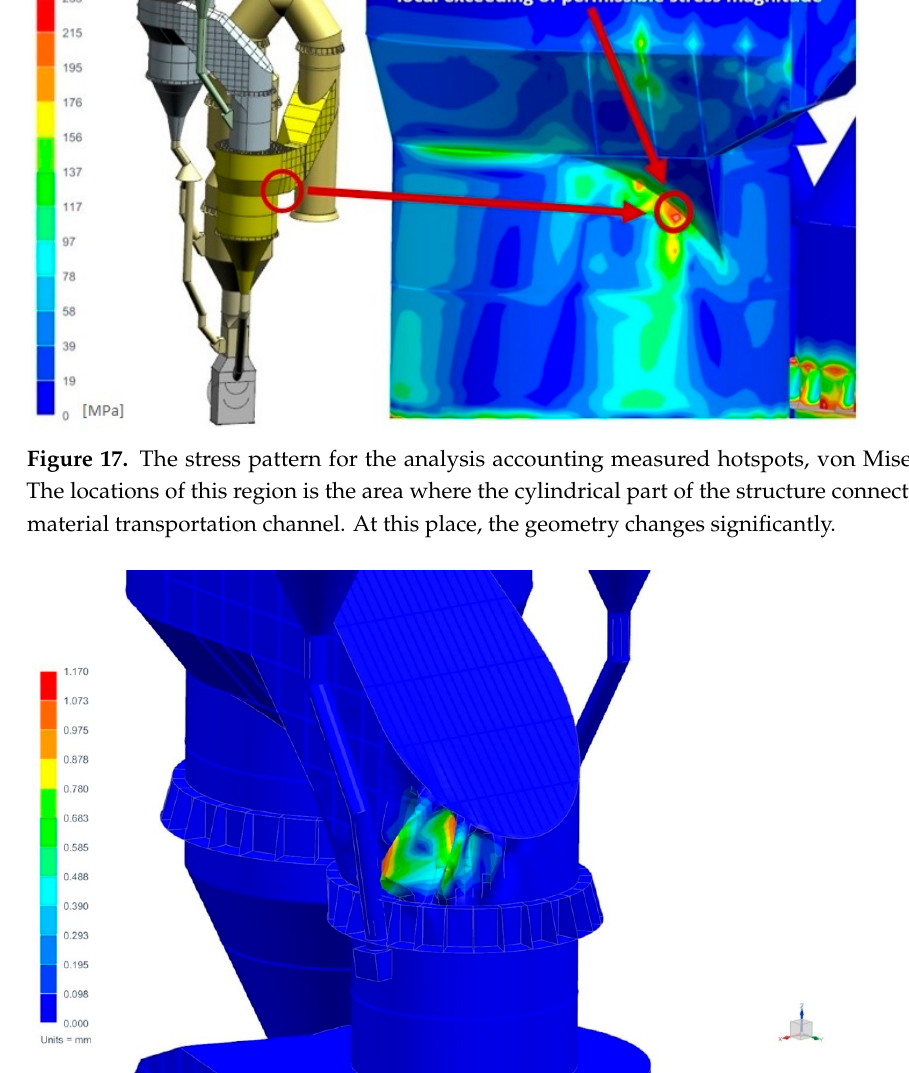
Figure 18. The global buckling mode of the